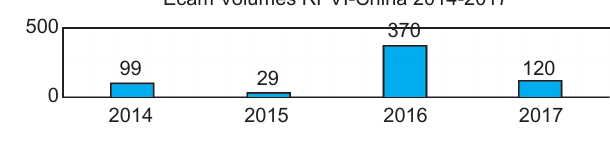
Figure 2 Exam Volumes for RPVI-China